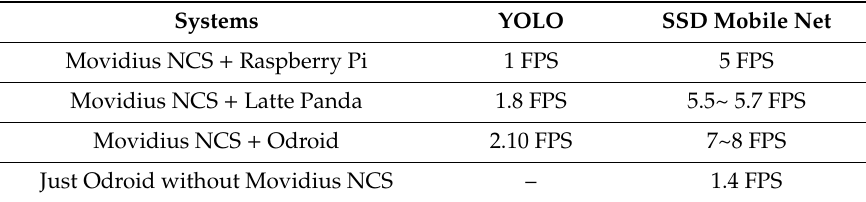
Table 6. Performance comparison between Raspberry Pi 3, Latte Panda, and Odroid Xu4.